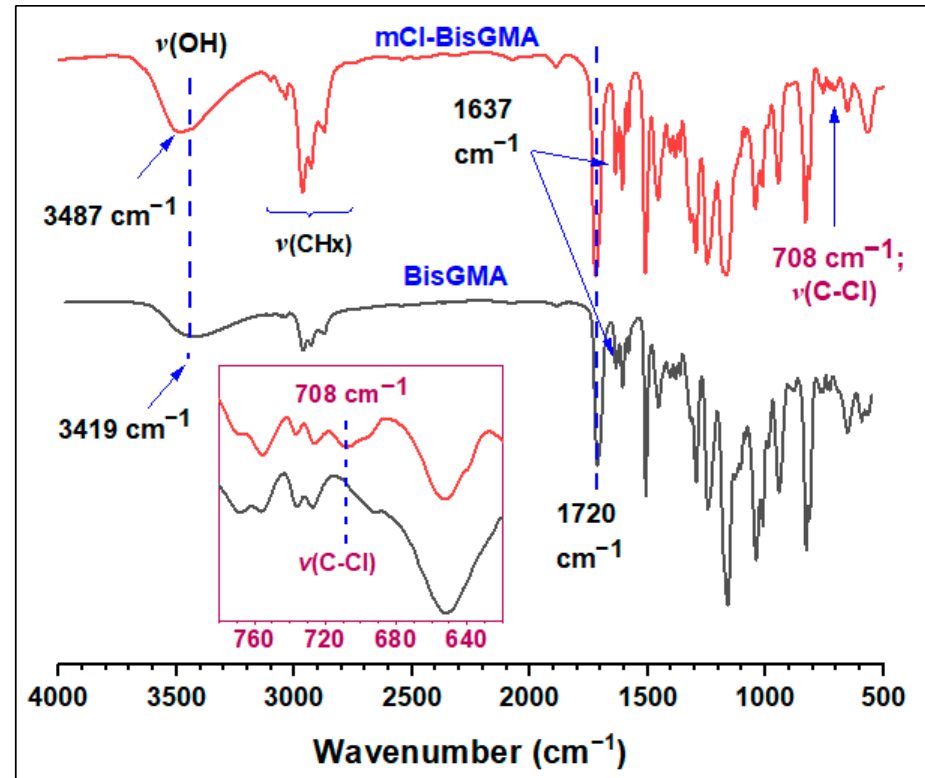
Figure 2. FTIR spectra of BisGMA and mCl-BisGMA monomers. The insert is a magnification of the C–Cl bond stretching vibrational